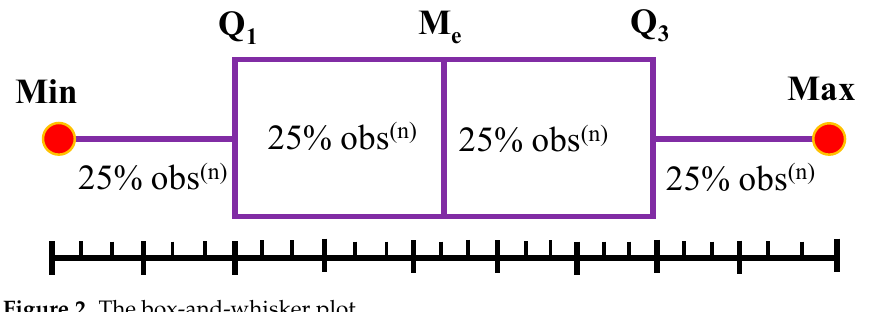
Figure 2. The box-and-whisker plot.